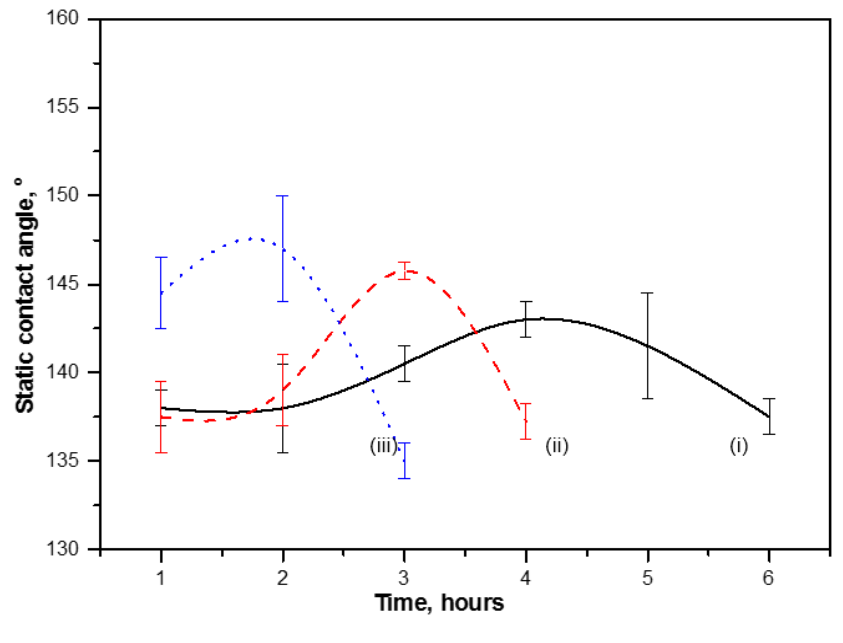
Figure 14. Static water contact angle evolution for cured modified MFC films after curing at (i) 100; (ii) 150 and (iii) 220 °C for different